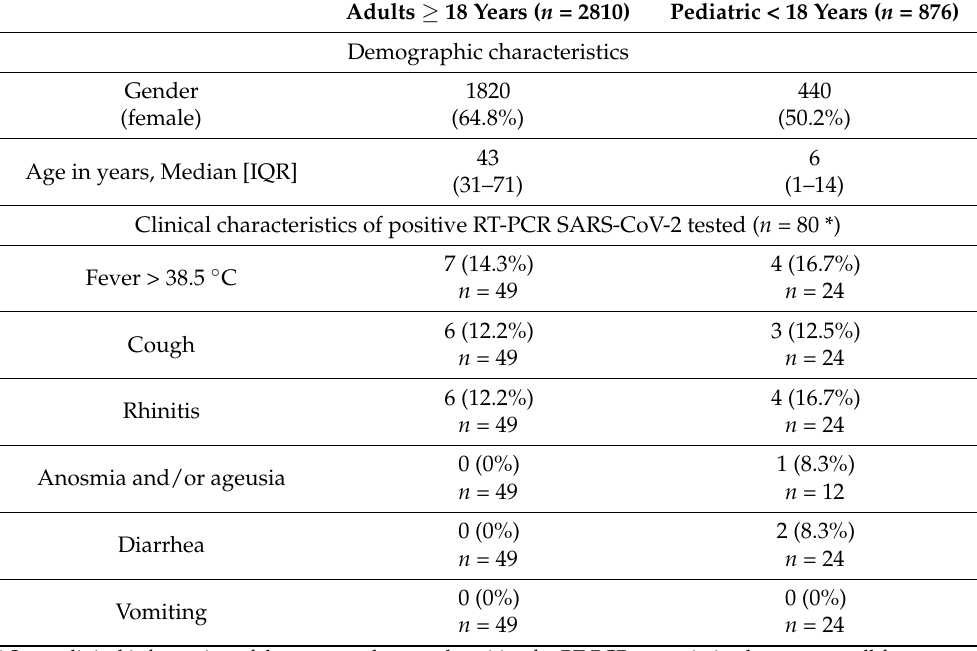
Table 1. Demographic and clinical distribution of